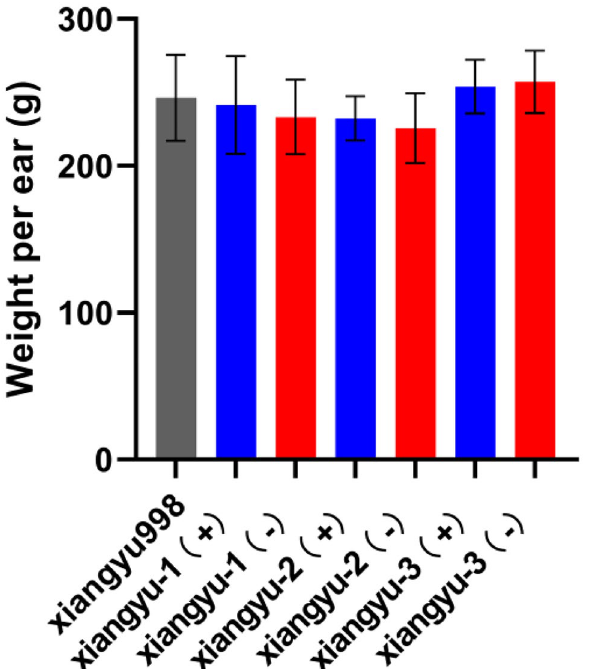
Figure 4. Weight per ear of different hybrids compared with commercial varieties. xiangyu-1( +), xiangyu-2( +), xiangyu-3( +): Transgenic hybrids; xiangyu-1(-), xiangyu-2(-), xiangyu-3(-):Negative separation